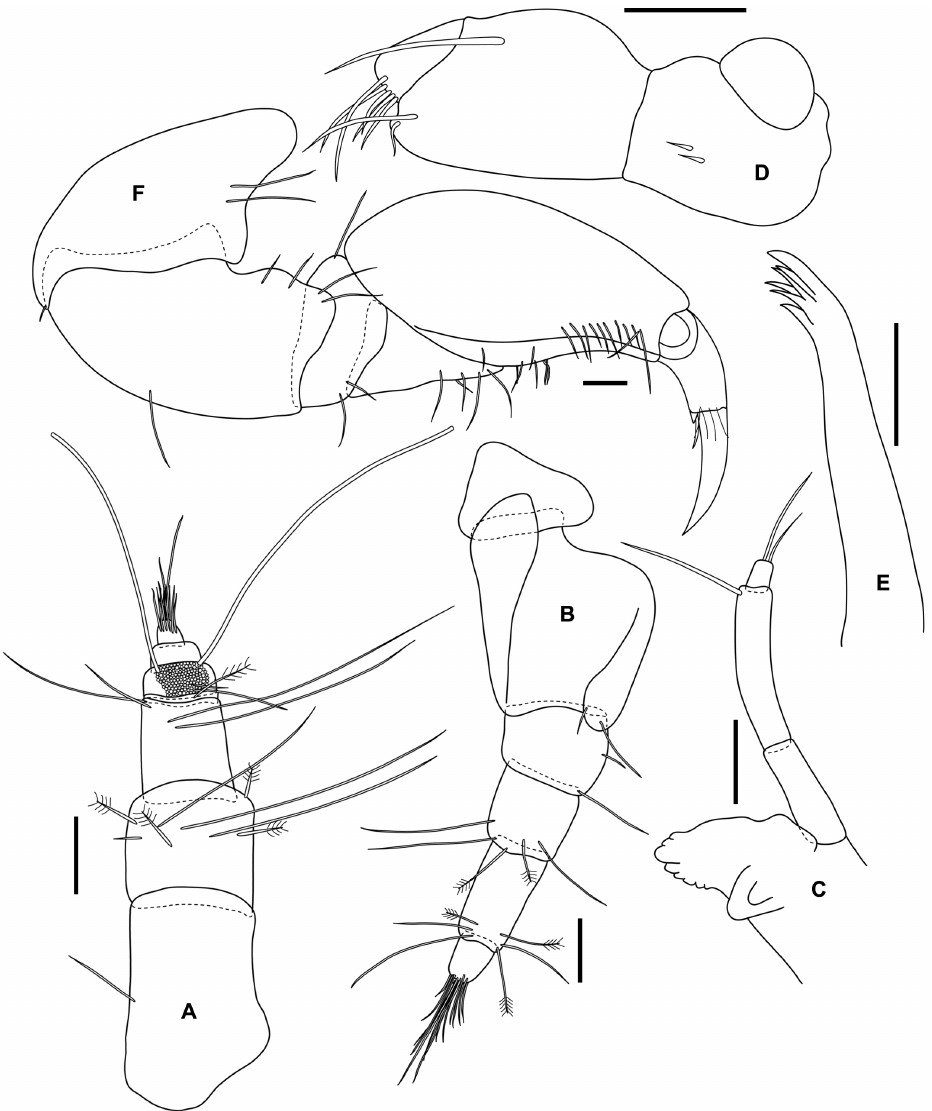
Figure 7. Tinggianthuraalba sp. n., allotype, male, (UKMMZ-1480). All scales represent 0.05 mm. (A) antenna 1, (B) antenna 2, (C) mandible, (D) maxilla, (E) maxilliped, (F) pereopod